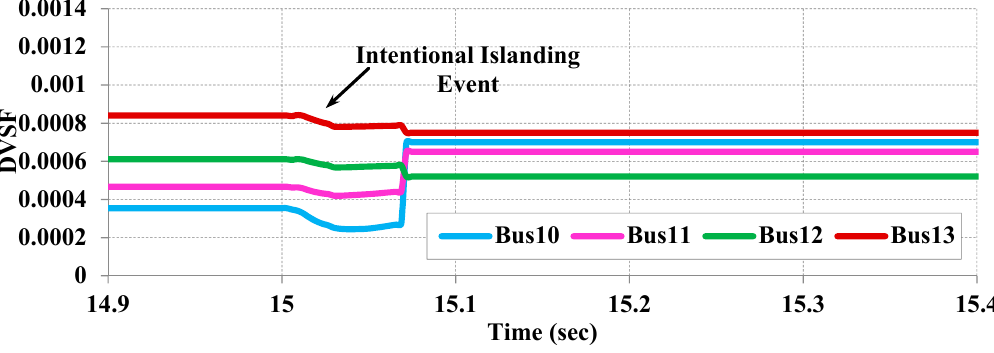
Figure 13. Voltage sensitivity indices using proposed boundary detection method.